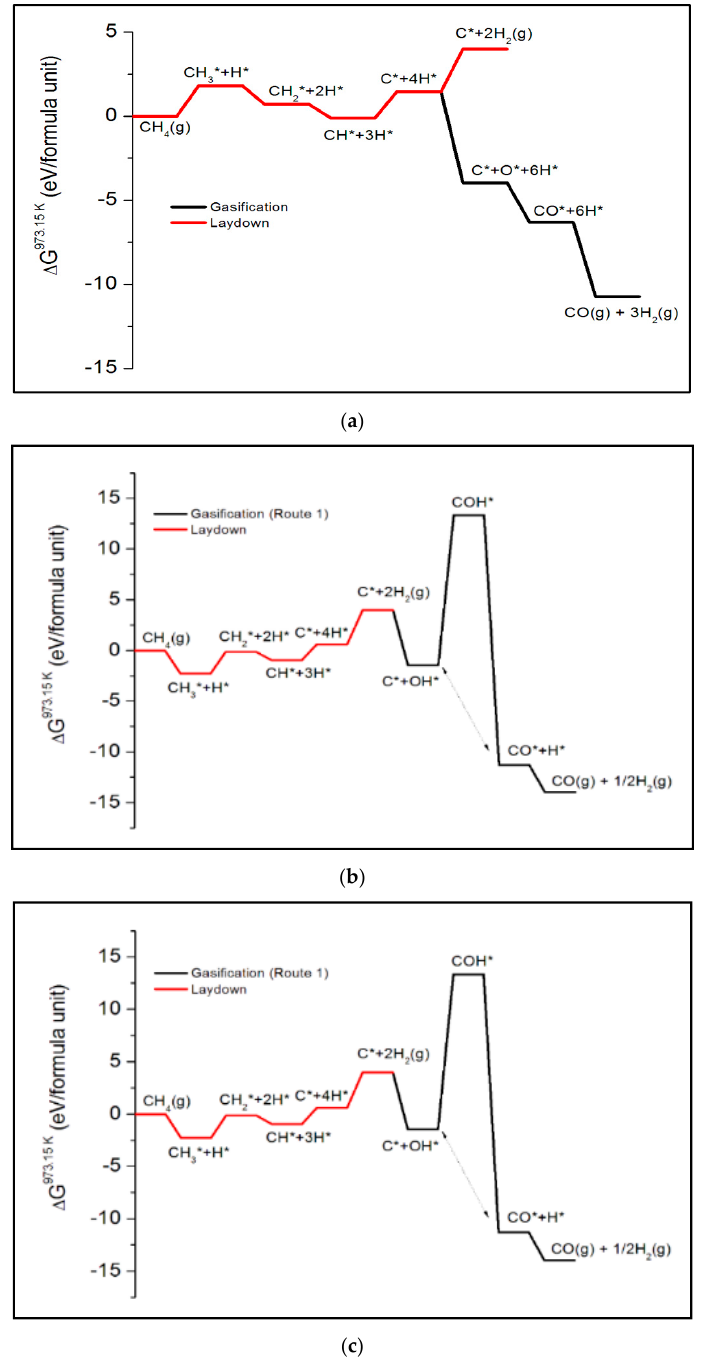
Figure 9. Thermodynamic reaction profile at 973 K showing the CO*( a ), COH*( b ), and CHO*( c ) routes for the monomeric carbon burn-off mechanism modelled on the Ni(322) step surface.